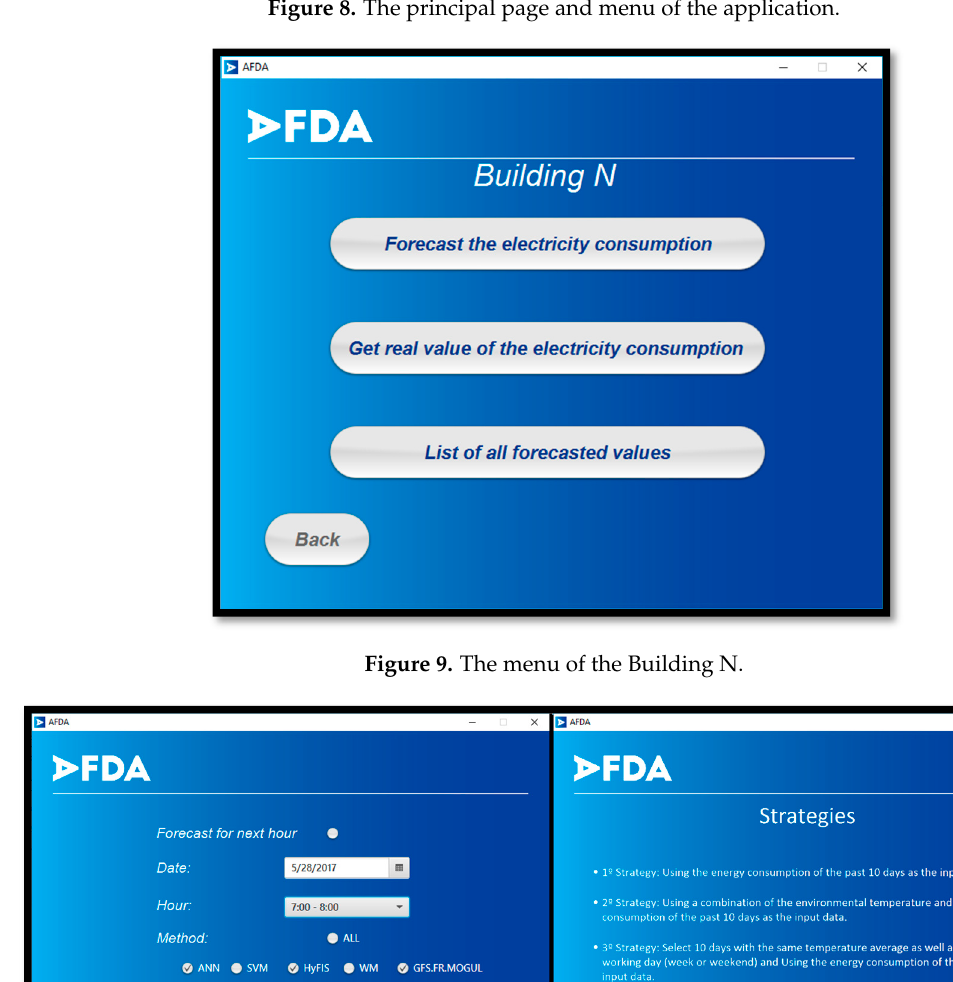
Figure 9. The menu of the Building N.